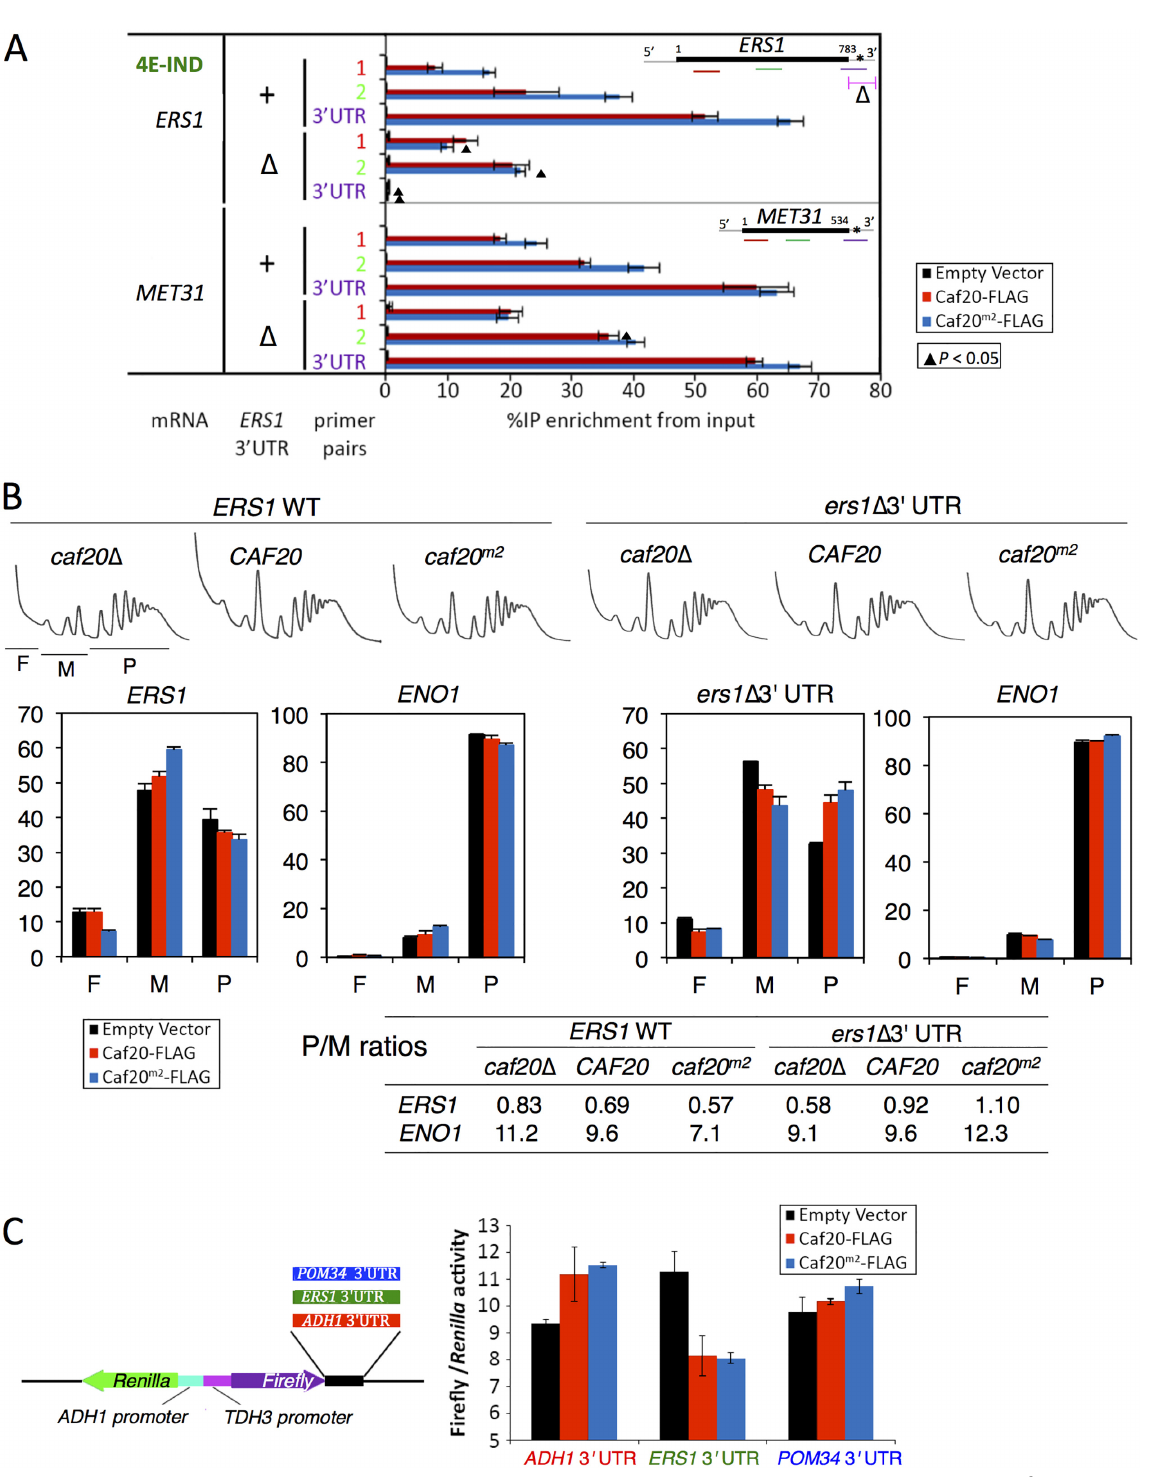
Fig 7. Caf20p and ERS1 3 ’ UTR contribute to the translational repression of ERS1 . A. Interactions between Caf20 m2 -FLAG and ERS1 is diminished by loss of ERS1 3 ’ UTR. Fraction of ERS1 or MET31 RNA (left) isolated in complex with Caf20-FLAG (red) or Caf20 m2 -FLAG (blue bars) or an empty vector control (black bars) from caf20 Δ cells following formaldehyde cross-linking and RNase III digestion. qRT-PCR detection with primer pairs hybridizing along each RNA as indicated by colour coding in each cartoon (right). Statistically significant changes ± ERS1 3 ’ UTR indicated by ▲ (T-test). B. Polysome engagement of ERS1 is affected by Caf20p and the ERS1 3 ’ UTR. Polysome profiles from sucrose gradient analyses of strains are shown (top) with free